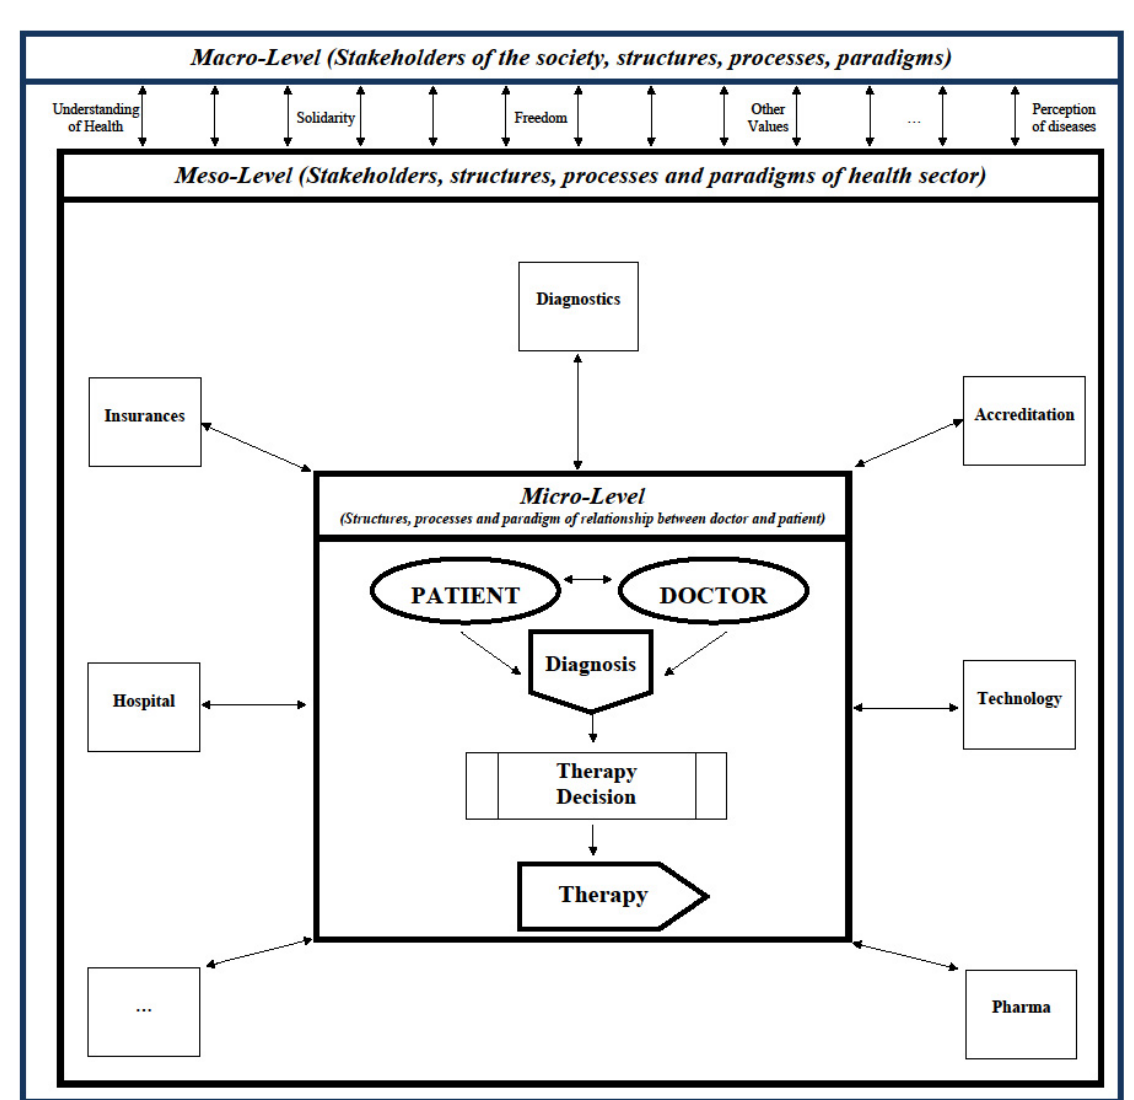
Figure 1. Micro-, Meso- and Macro-Innovation.